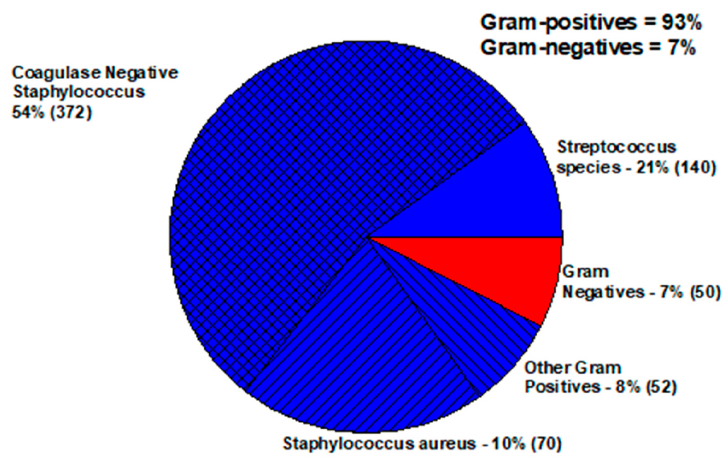
Figure 1. Bacterial pathogens of endophthalmitis.